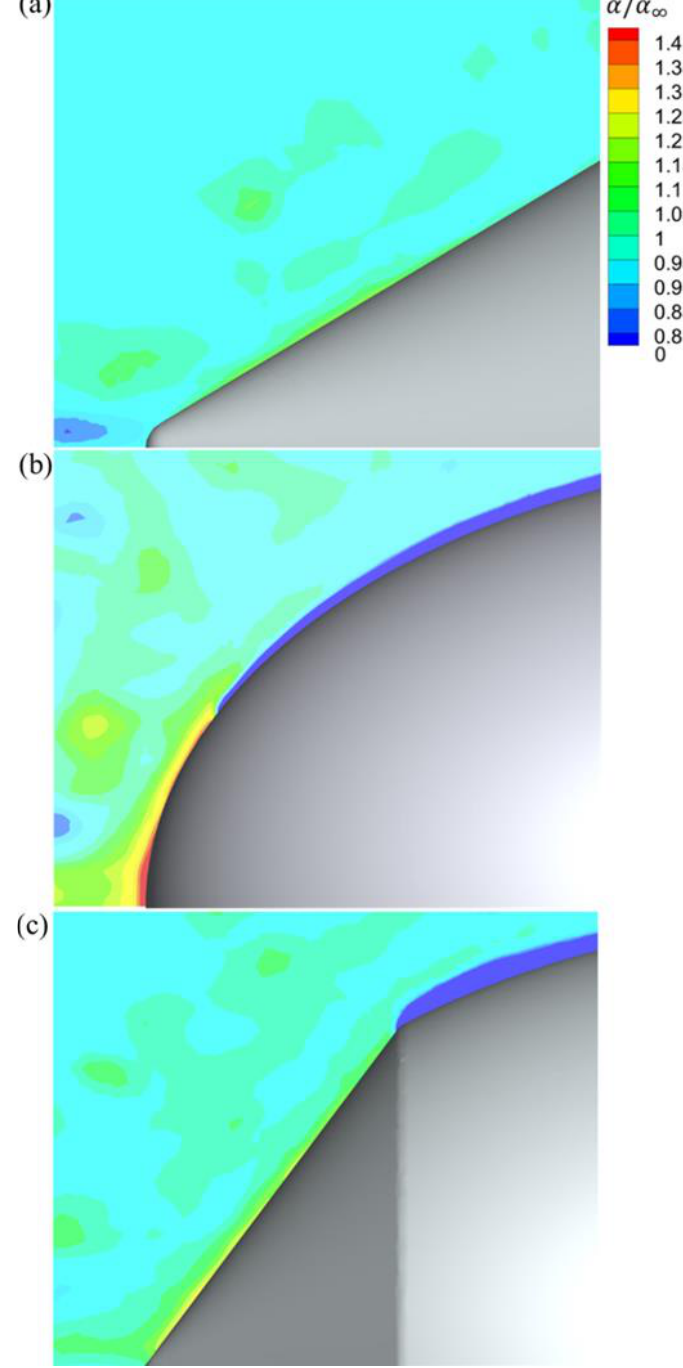
Figure 10. Distribution of the ratio of the local water volume fraction ( 𝛼 ) to the water volume fraction at the inlet ( 𝛼 ∞ ): ( a ) conical spinner; ( b ) elliptical spinner; ( c ) coniptical spinner.